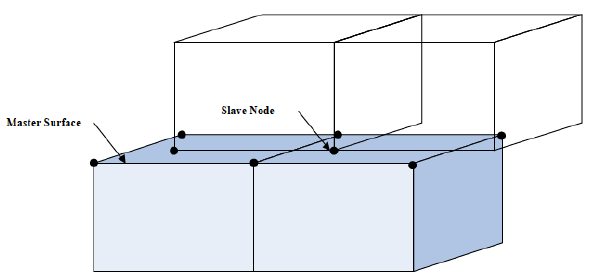
Figure 4: Node-to-surface compatibility